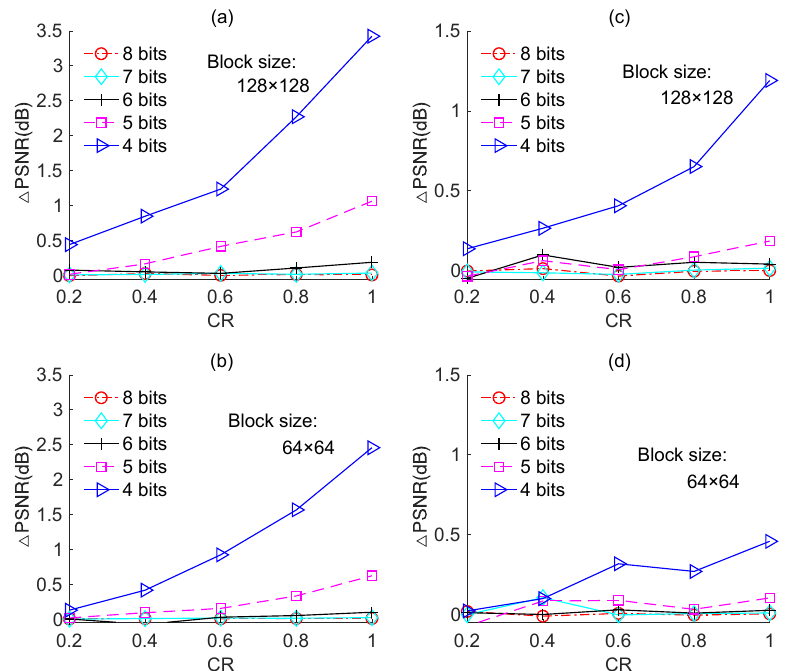
Figure 11. PSNR losses of the quantized BCS with different resolutions of ADC for the “Boats” image. ( a , b ) are based on Zadoff–Chu measurement matrix; ( c , d ) are based on real-valued Hadamard measurement matrix.